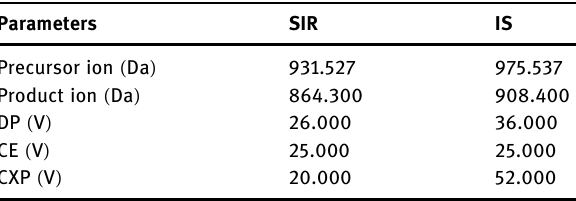
Table 1: The mass spectrometry conditions for the analysis of SIR and IS